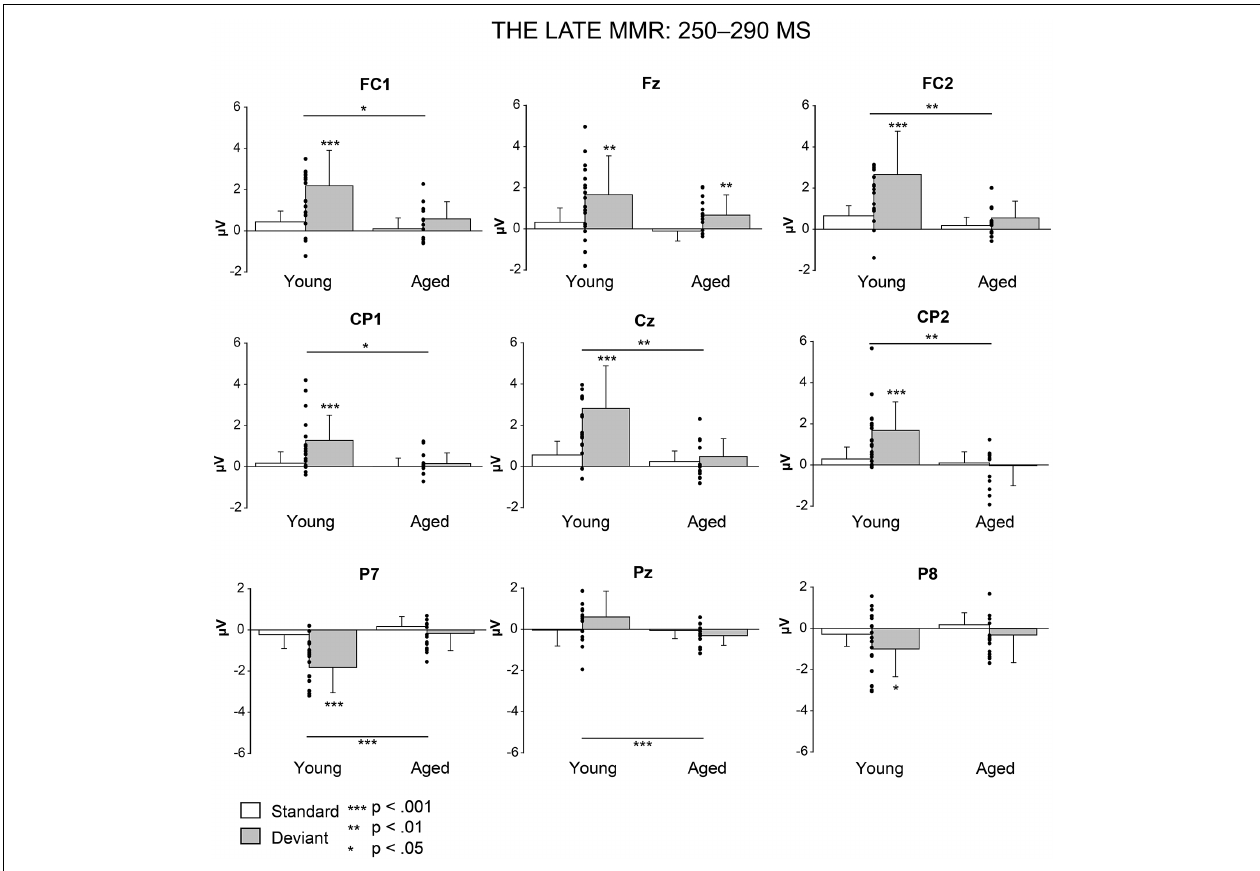
FIGURE 5 | Mean amplitudes and standard deviations to deviant and standard stimuli responses on analyzed electrode sites in young and aged. Values of the differential response (deviants minus standards, i.e., MMR) of the individual participants’ are shown as